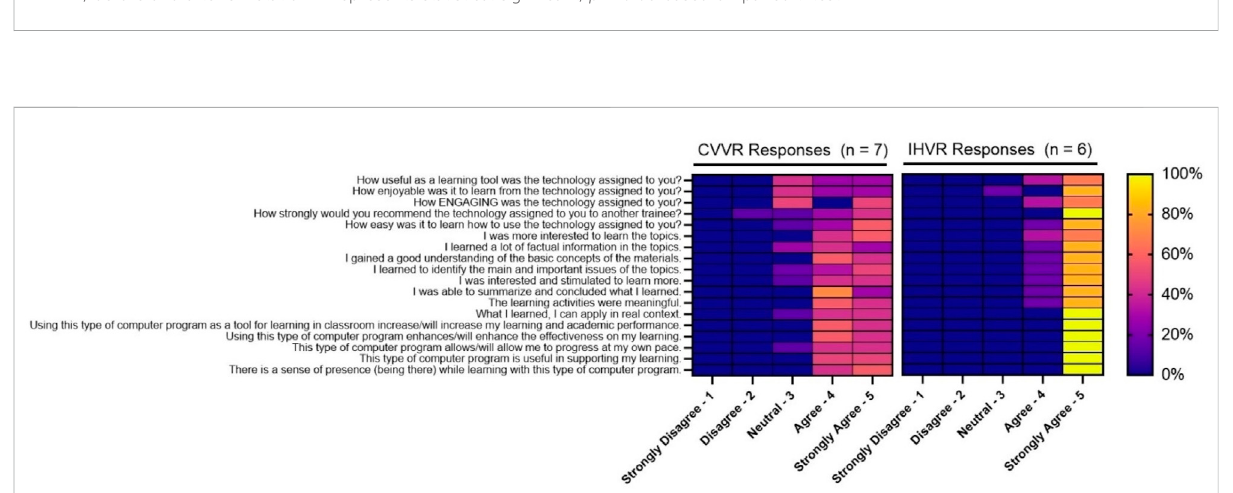
FIGURE 1 Median Pre-simulation and Post-simulation self-reported (A) overall con fi dence, (B) perceived insertion skill, (C) perceived insertion skill, and (D) comfort with independently performing. Bar graph represents the median response score ± 95% con fi dence interval in each group, CVVR and IHVR, before and after simulation. * represents statistical signi fi cant, p < 0.05 based on paired t -test.